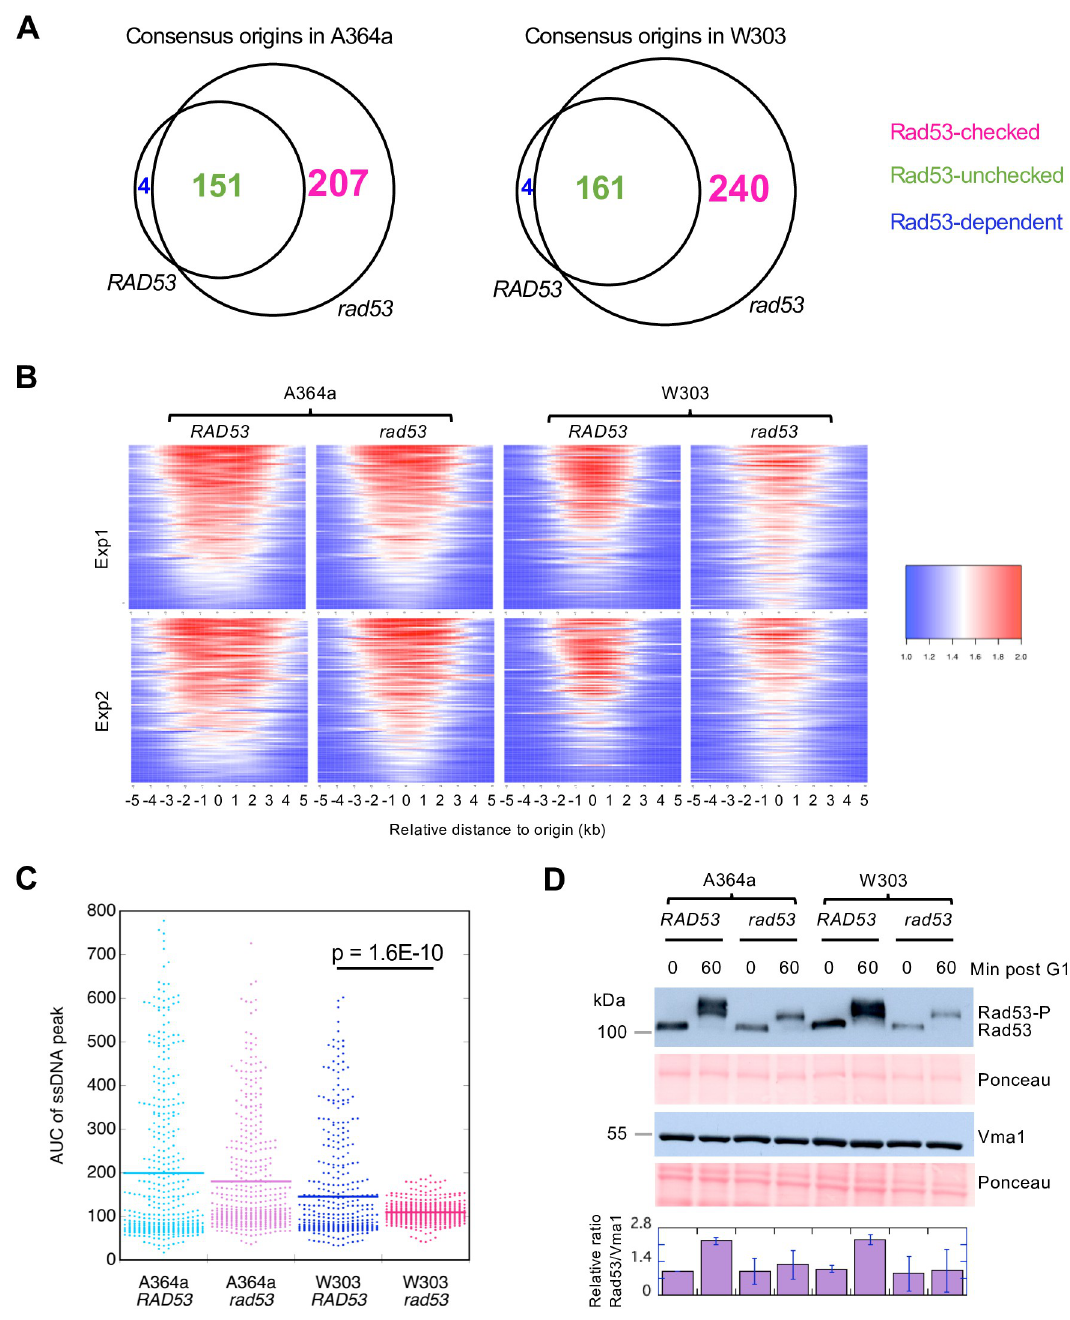
Fig 2. Comparative analysis of origins of replication in the A364a and W303 background. (A) Consensus origins identified by both biological replicate experiments in the A364a (left) and W303 (right) background, respectively, were divided into three classes of origins, “Rad53-unchecked”, “Rad53-checked”, and “Rad53-dependent”, based on the comparison between RAD53 and rad53 cells. See text for detail. ( B) Heatmaps of the normalized ssDNA ratios (compressed to a scale of 1 to 2) from the 419 unique origins from (A) in each of the four strains. (C) Quantification of average AUC values for the uncompressed ssDNA signals at the 419 origins in each strain from two experiments. (D) Western blots of Rad53 levels in cells at 0 or 60 min post release from G1 arrest into S phase in the presence of 200 mM HU, respectively. A cellular protein Vma1 was used as loading control. Overall protein levels were also controlled by Ponceau staining. The Rad53 level was quantified as the ratio of Rad53/Vma1. Each ratio was then normalized to the ratio from A364a_ RAD53 cells, which was set to 1. Data from three independent measurements were averaged and plotted. Error bars stand for standard deviation.